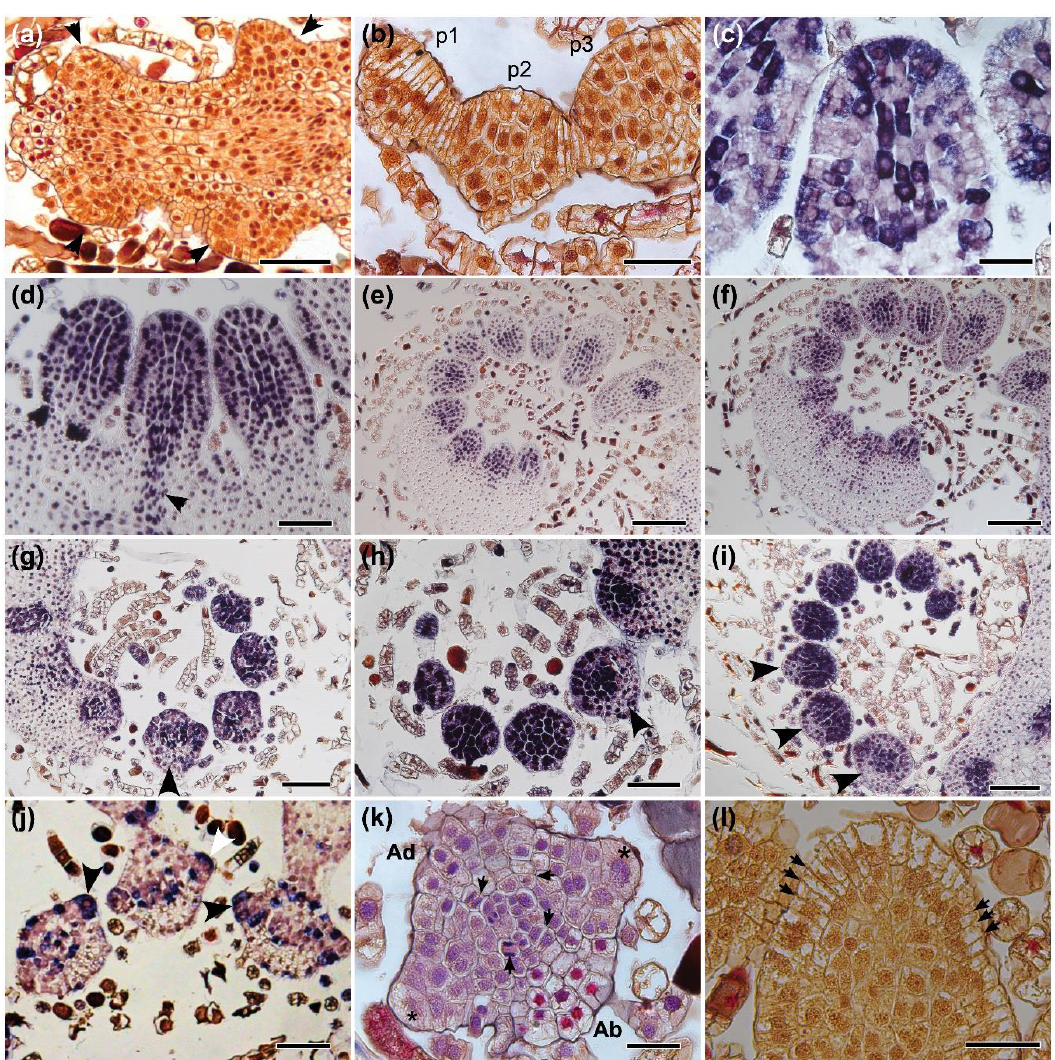
Figure 4. Late leaf development in terrestrial (Tf) and climbing (Cf) forms of Mickelia scandens by anatomical and expression analyses. Anatomical sections ( a , b , k , l ). ( a ) Pinnae primordia (arrowheads) emerge from the margins of the Tf leaf. ( b ) Transverse section of the youngest pinna (p1) shows grouped cells on its apex with evident periclinal divisions in Tf. The base has divisions in multiple planes, visible in older primordia (p2 and p3). In situ hybridization ( c – j ). ( c ) MsH4 expression indicates cells division in multiple adjacent cells at the apex of the pinna primordium and in the central axis, where the vasculature will develop in the Tf. ( d ) As the pinnae primordium increases in size, developing vascular traces express Class I KNOX genes, exemplified by MsC1KNOX1 in Cf. ( e ) MsC1KNOX1 in Cf and ( f ) MsC1KNOX2 in Cf are expressed in the entire young pinnae primordia. ( g ) MsH4 in Tf, ( h ) MsC1KNOX1 in Tf and ( i ) MsC1KNOX2 in Cf are all expressed throughout the entire pinnae primordia, expression is gradually reduced in the abaxial side of older pinnae (arrowheads). ( j ) Cell divisions detected by MsH4 expression in marginal cells, some indicated by arrows in Tf. ( k ) Anatomical transverse section of the pinna primordium showing marginal cells (*) with outer lenticular faces of the wall and submarginal initials, between adaxial (Ad) and abaxial (Ab) sides, and radial divisions in the center (arrows) in Cf. ( l ) Anatomical paradermal section of the pinna primordium showing rows of marginal cells, with anticlinal cutting faces, some indicated with arrows in Cf. Bars: ( a , d , h , j ) 100, ( b , c , k , l ) 50, ( e , f ) 200, ( g , i ) 150 µm. Our initial hypothesis was that Class I KNOX expression was stronger and longer in the developing leaves of the climbing form (that are bigger and bear more pinnae, supposedly